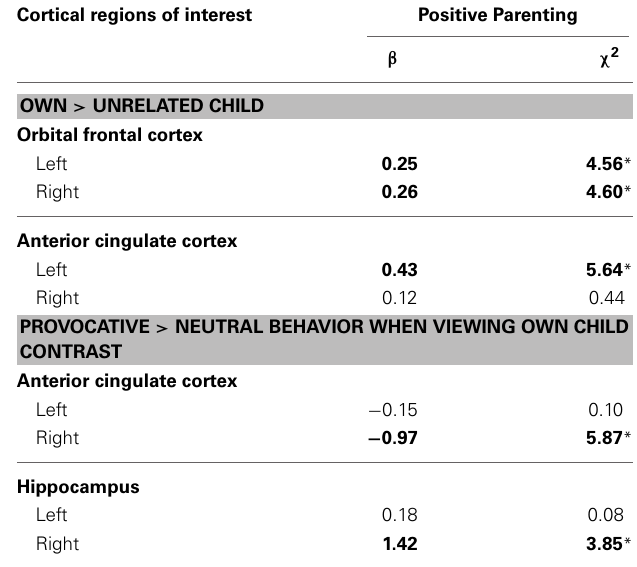
Table 2 | Tests of associations between observed maternal positive parenting and maternal BOLD activations by the two kids of stimuli in brain regions of interest using small-volume correction ( N = 34).